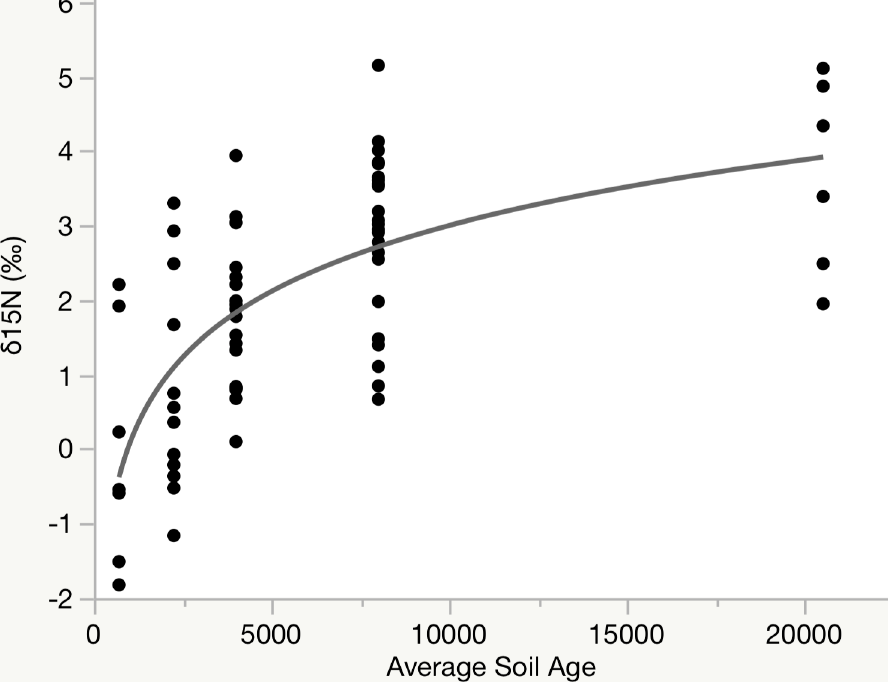
Fig 3. δ 15 N values in kukui endocarp. Response in δ 15 N to soil age by average substrate age of the age class exhibiting a log-linear relationship.